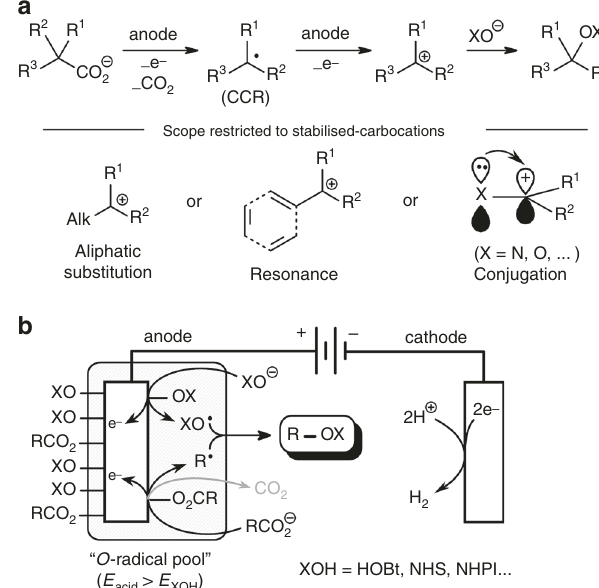
Fig. 1 Strategies for electrochemical decarboxylative C – O bond formation. a Hofer – Moest electrodecarboxylative C – O bond formation. b Electrodecarboxylative radical C – O